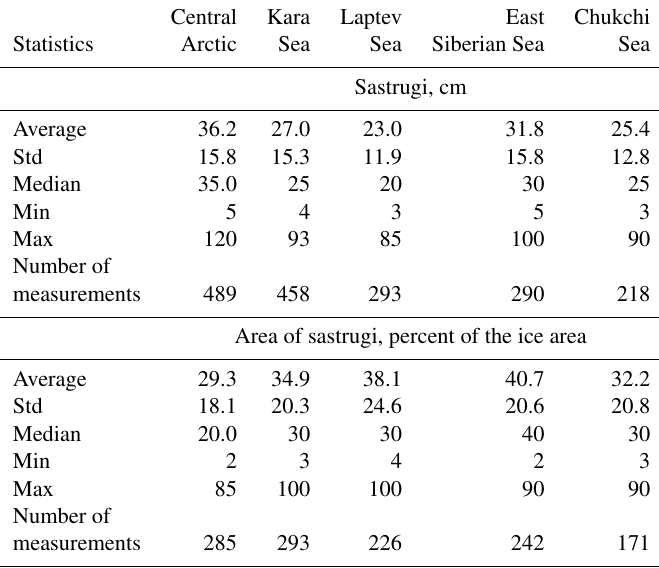
Table 3. Summary statistics of the height and area of sastrugi on the prevailing type of ice in the landing area in the central Arctic and in the marginal seas of the Arctic